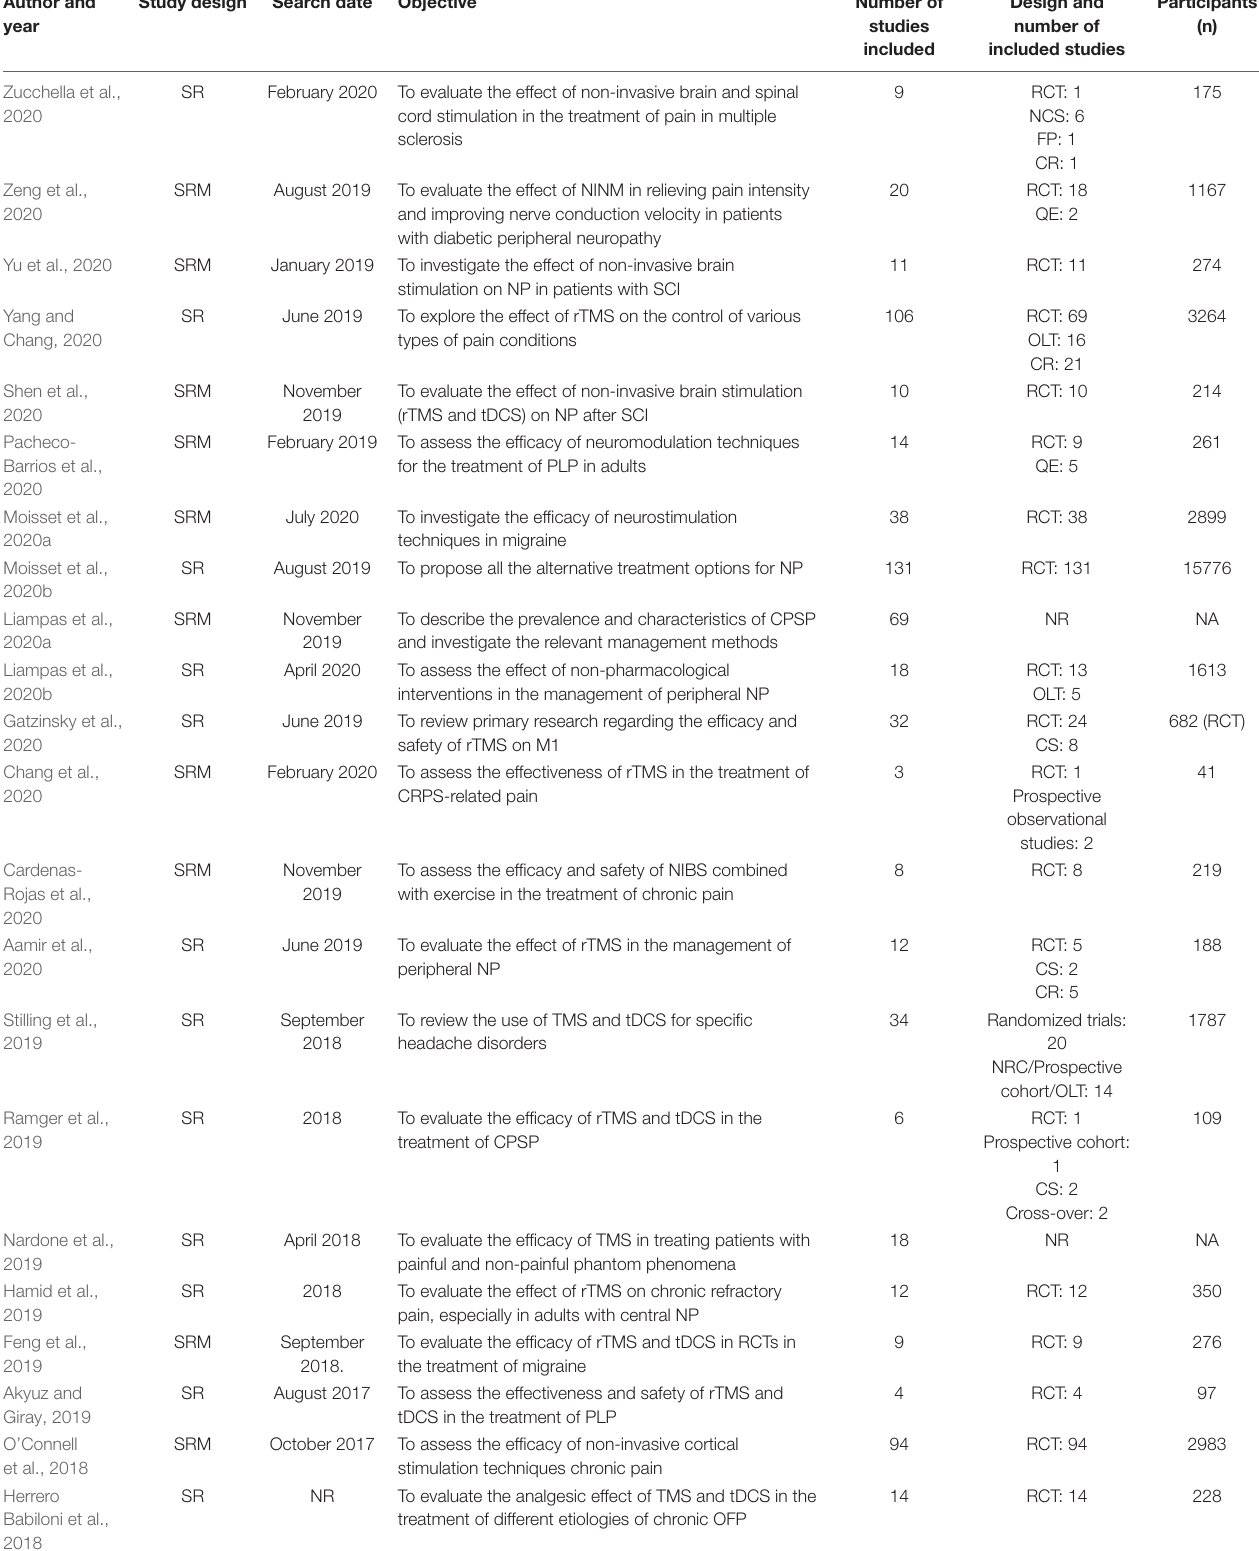
TABLE 1 | Characteristics of included systematic